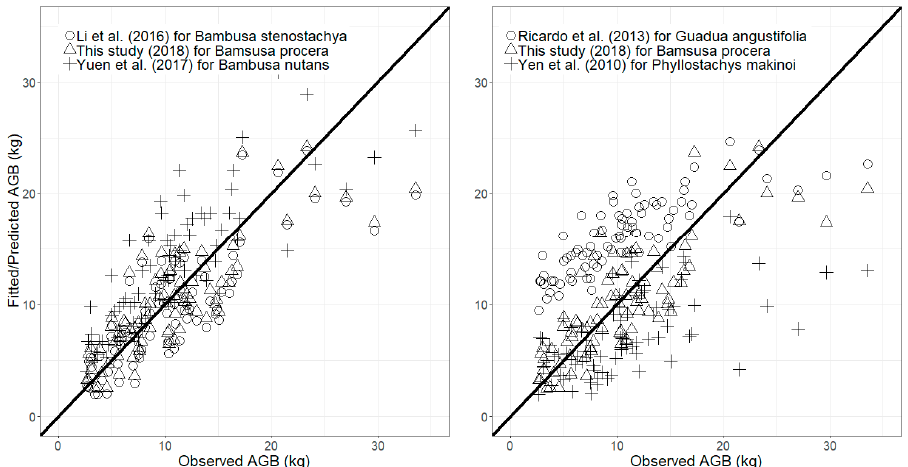
Figure 5. Plots of Fitted/Predicted AGB vs. Observed AGB : ( left ) Comparison of selected model of this study with other models in the same genus Bambusa ; ( right ) comparison of selected Bambusa genus model of this study with other models in different genera. Table 6. Cross validation of AGB model fitted by SUR of this study and other AGB models worldwide with the different/same genus.